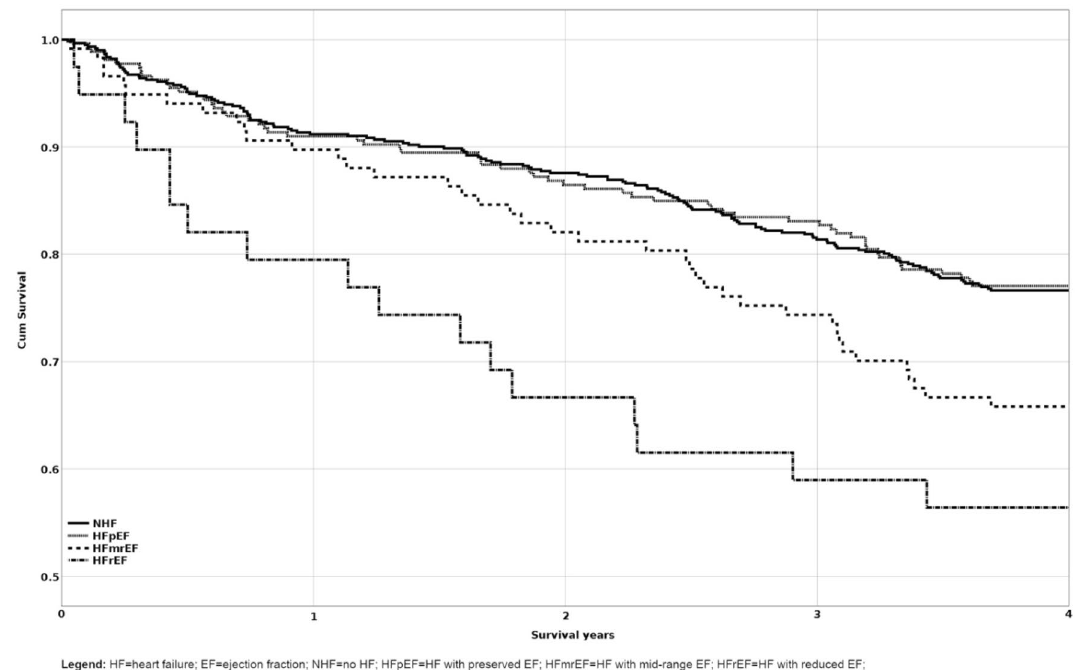
Figure 1. Kaplan Meier survival curves of EF groups for all-cause mortality.